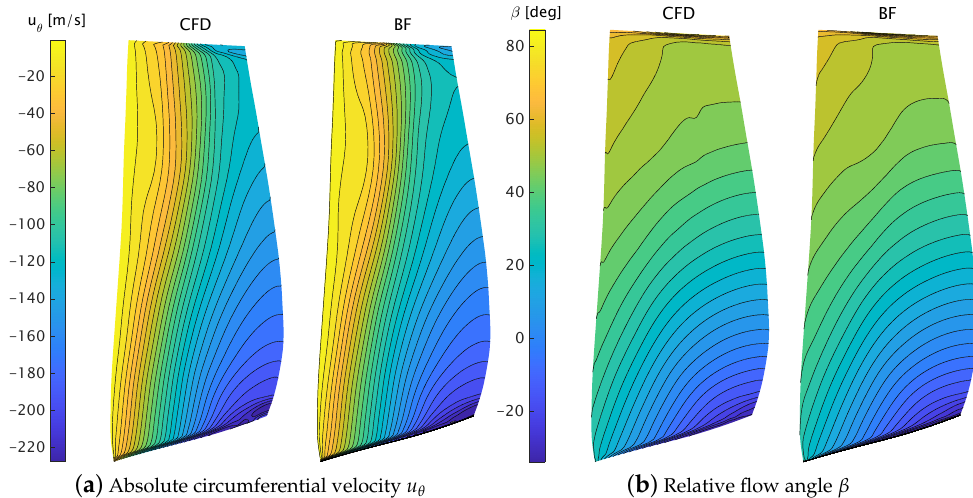
Figure 9. Absolute circumferential velocity and relative swirl angle contours on the blade for reference CFD solution and baseline body force model at peak